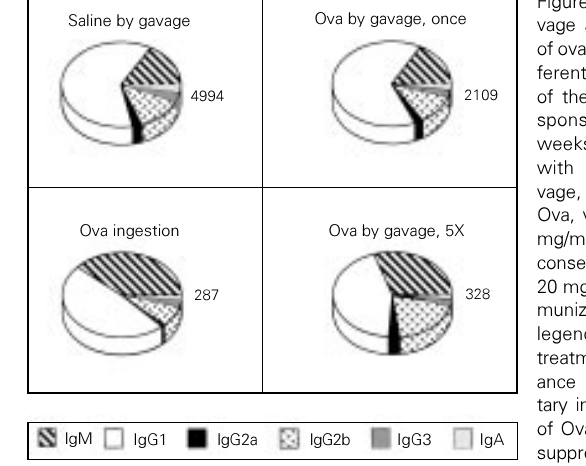
Figure 5 - Mice treated by ga- vage and voluntary ingestion of ovalbumin (Ova) show a dif- ferent pattern of suppression of their anti-Ova immune re- sponse. B6D2F1 mice at 8 weeks of age were treated with either salinene by ga- vage, one gavage of 20 mg Ova, voluntary ingestion of 4 mg/ml Ova for 5 days, or 5 consecutive daily gavages of 20 mg Ova. All mice were im- munized as described in the legend to Figure 1. All oral treatments induced oral toler- ance (P<0.001) while volun- tary ingestion and 5 gavages of Ova induced a preferential suppression of